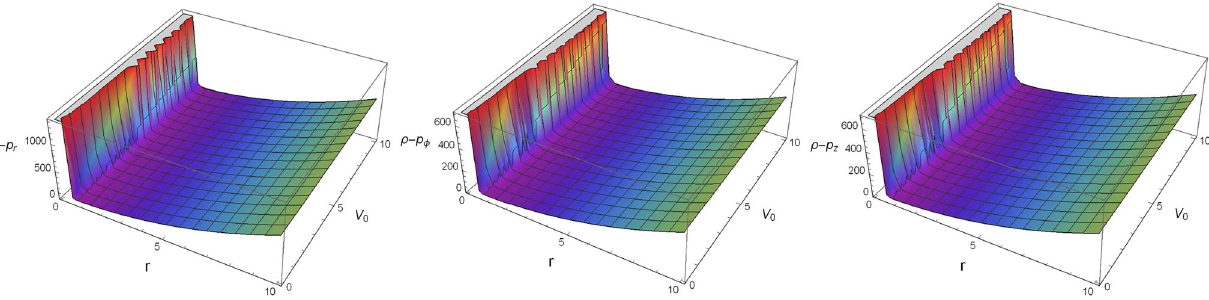
Fig. 36 These graphs shows the behavior of (ρ − p r ) (MeV/fm 3 ) , (ρ − p φ ) (MeV/fm 3 ) and (ρ − p z ) (MeV/fm 3 ) w.r.t r (km) with m = n =